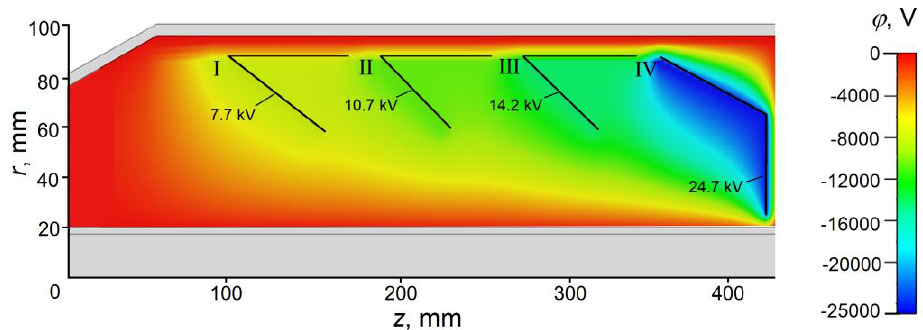
Fig. 4. Gradient image of electric potential distribution in the cross-section of recovery